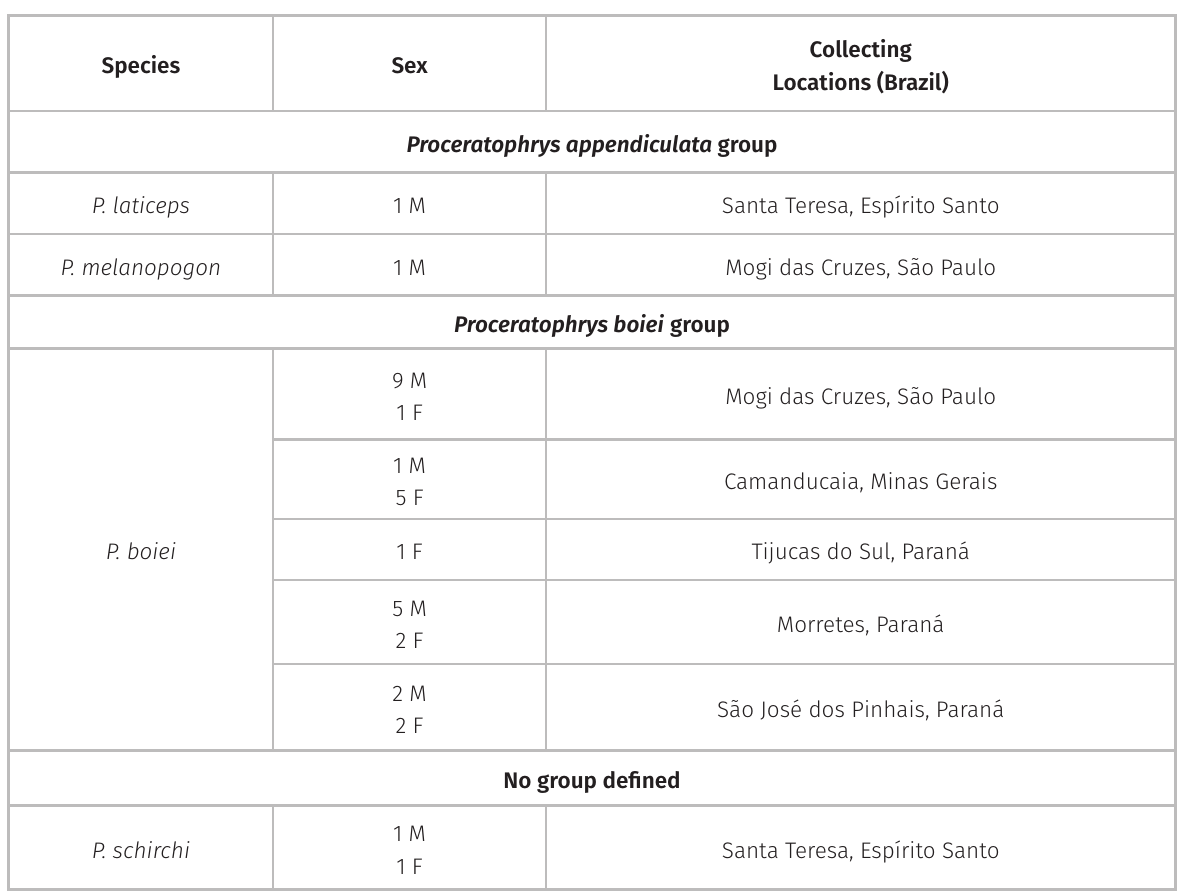
Table I. Species of Proceratophrys groups used in this study, with localizations of collected and number of species utilized. M: male; F: